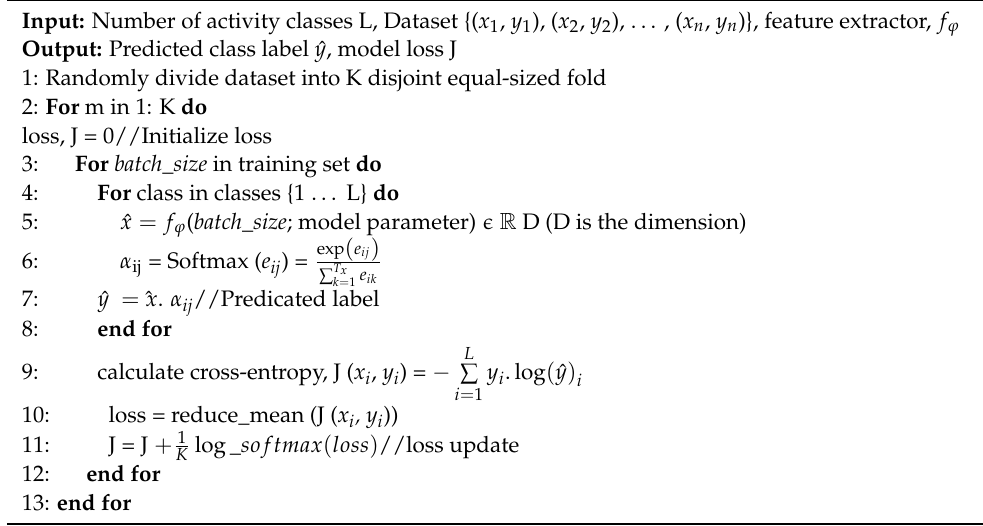
Algorithm 3: Pseudocode of class Prediction and Training Loss